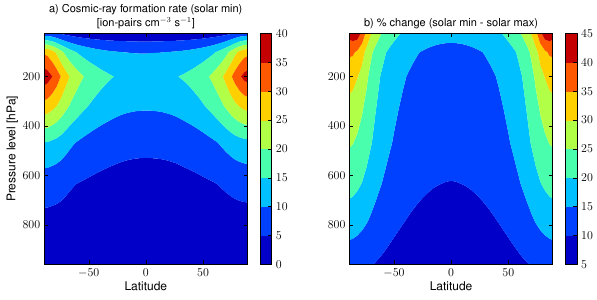
Fig. 2. (a) Zonal-mean ion-pair formation rate from cosmic rays as a function for solar-min (modulation potential =0.4 GV). (b) Zonal-mean percent change in ion formation rate from cosmic rays between solar min (0.4GV) and solar max (1GV) where higher ion formation rates occur during solar min. Ion formation rates are cal- culated using the method of Usoskin and Kovaltsov